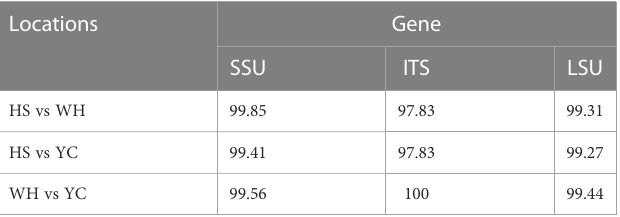
TABLE 2 Percentage of sequence similarity of the rDNA of the Neo fl abelliforma dubium n. sp. isolated from different geographical